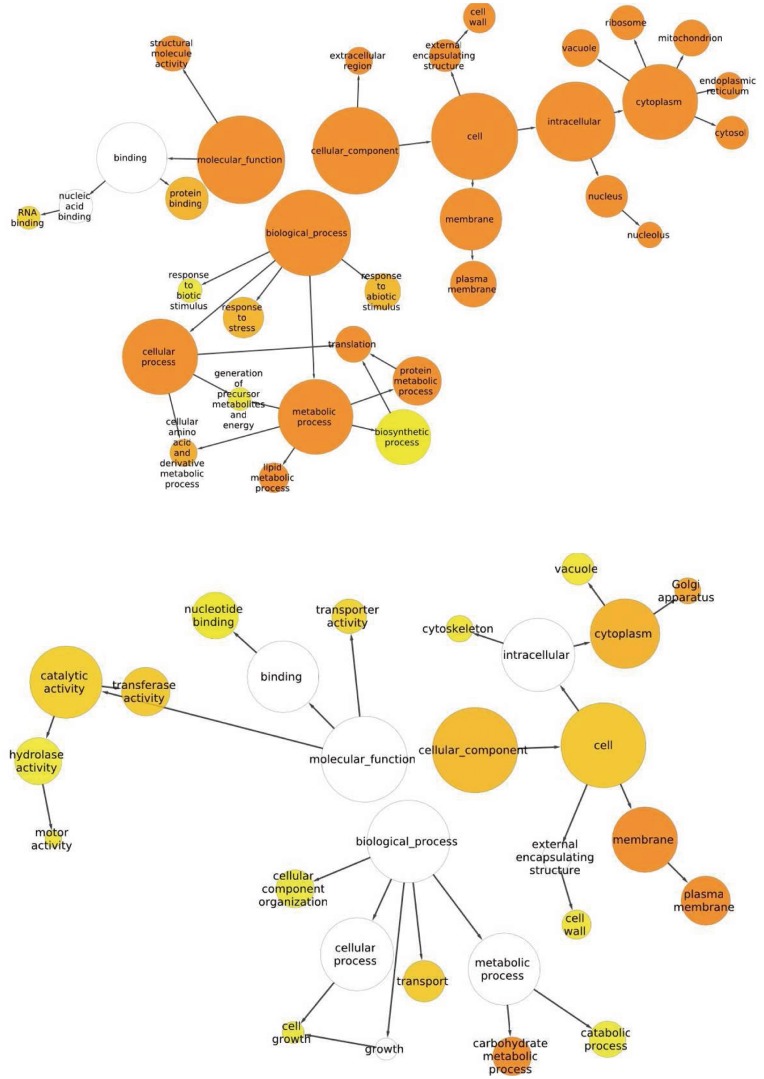
GO enrichment analysis between fiber development stages.The Gossip package of Blast2GO was used. Over representation of functional classes are presented among contigs with significant DGE (over-expression) at 10 compared to 22 dpa (upper Figure) and at 22 compared to 10 dpa (lower Figure). Significantly enriched GO terms (P<0.05) are highlighted, and the degree of color saturation of each node positively correlates with the enrichment significance of the corresponding GO term. Box color represent significance ranging from white for least significant to dark orange for most significant enrichment, arrows indicate hierarchical relationships.